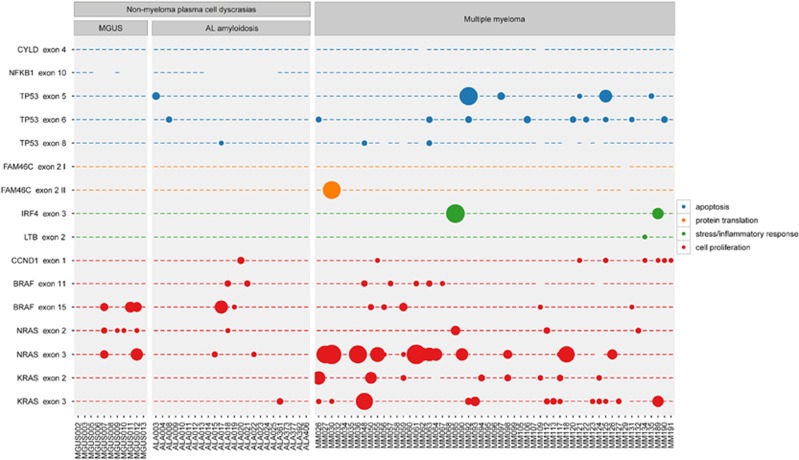
Mutated clones detected by NGS in the MGUS, AL amyloidosis and myeloma cohorts. Genes regulating cell proliferation (red circles), stress and inflammatory response (green circles), apoptosis (blue circles) and protein translation (orange circles) are shown.